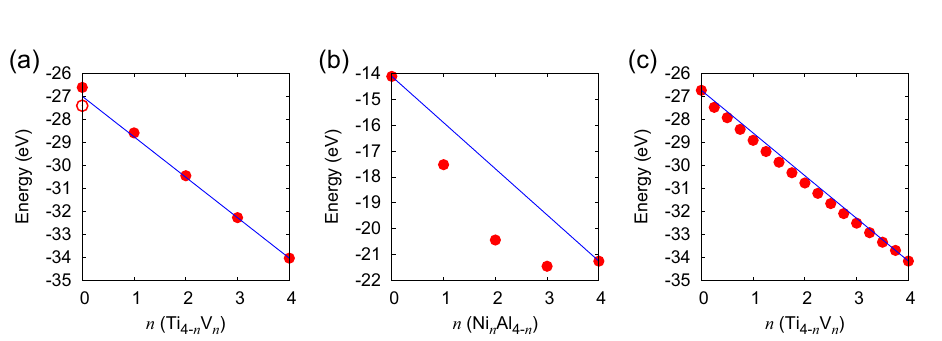
n V n (the open circle is the energy of hcp Ti, while the − n , and ( c ) the SQS-based energy −